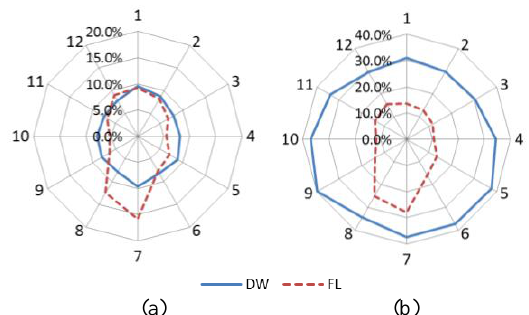
Figure 6. Monthly variations: (a) proportion to each type of fire;